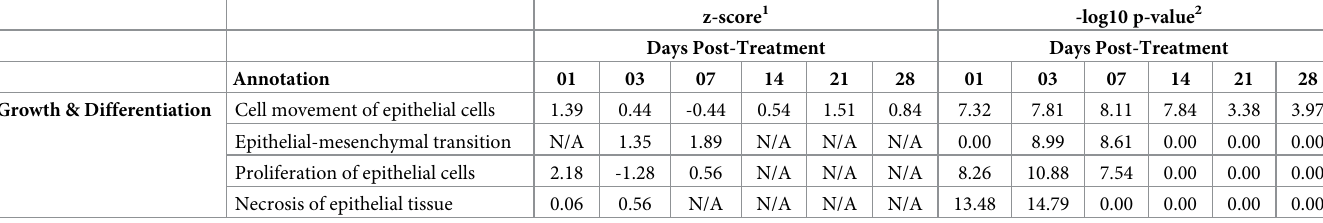
Table 3. Epidermal-related biological pathways associated with laser resurfacing